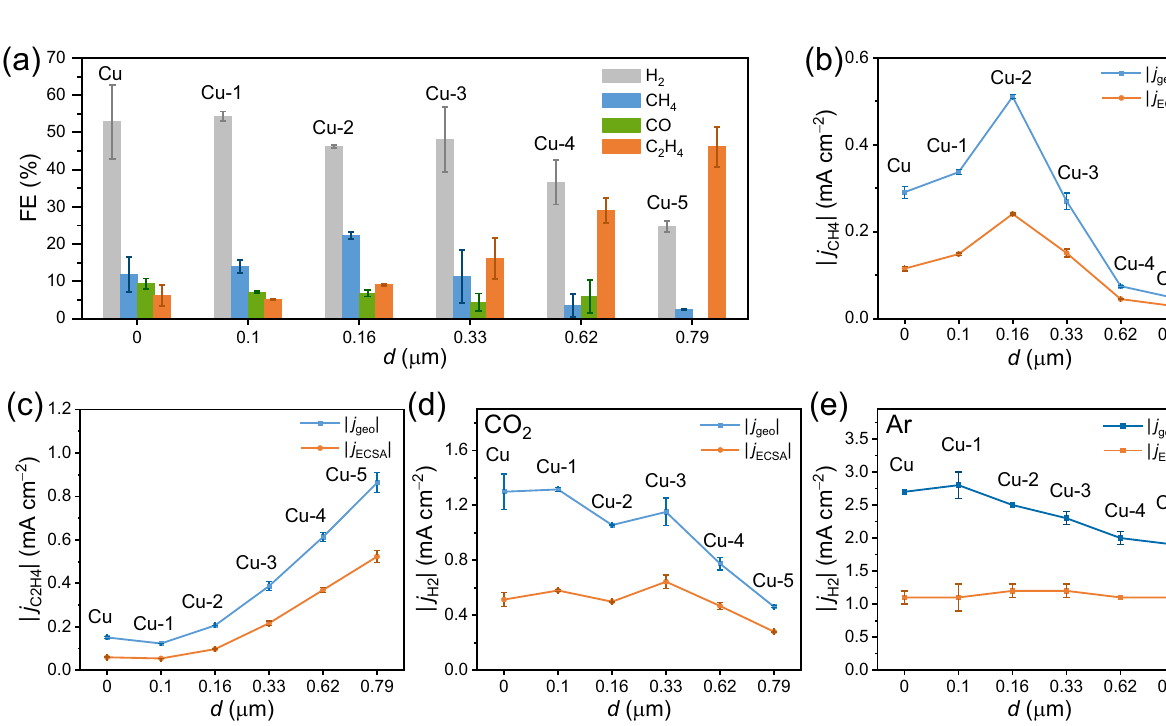
conducted at an applied potential of − 0.96V versus RHE for 60 min in CO 2 -satu- rated or Ar-saturated 0.1M KHCO 3 , unless noted otherwise. Error bars correspond to the standard deviation of at least two independent measurements. Source data are provided as a Source Data fi